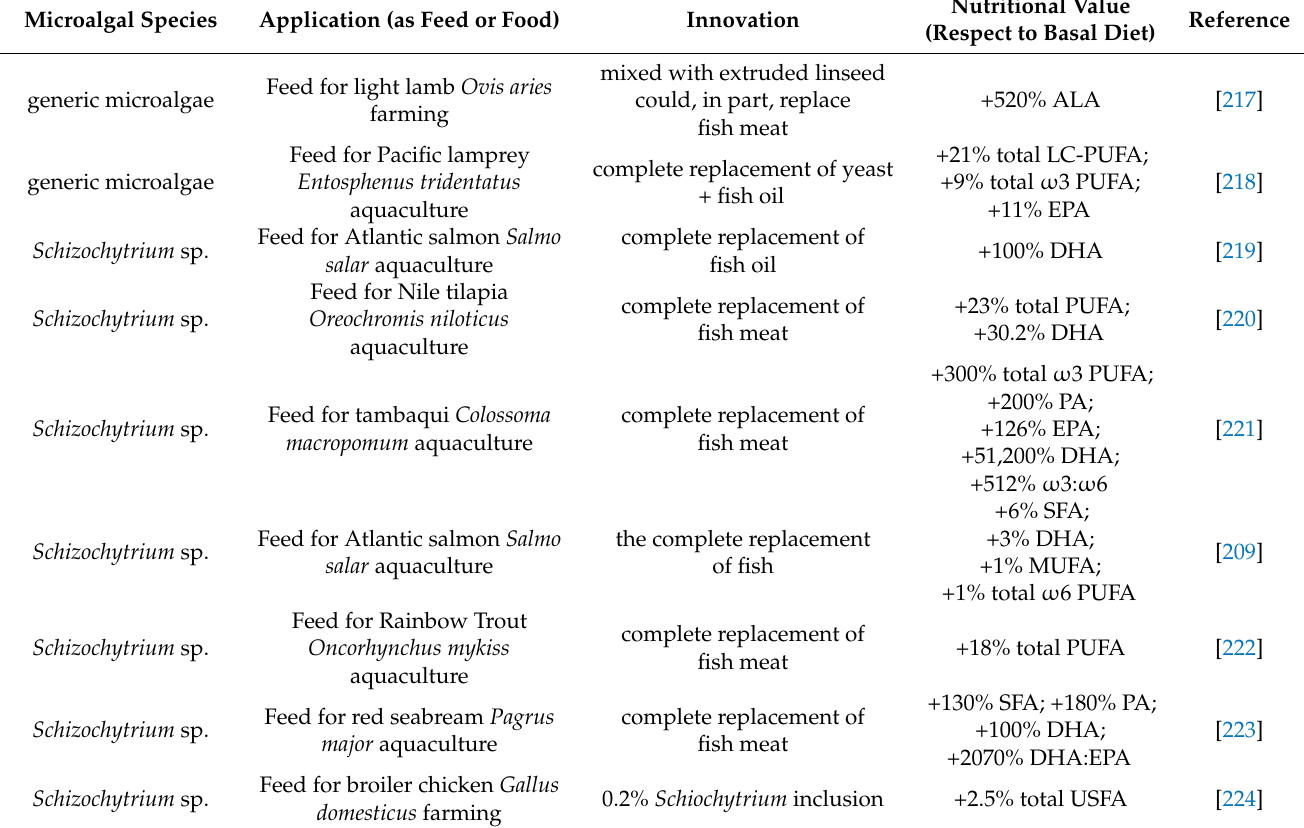
Table 3. Microalgae and their derivatives used as feed in farming or aquaculture. The table includes microalgal species involved, application as feed, innovations, and nutritional values indicated as percentage increase respect to a basal diet. Microalgal Species Application (as Feed or Food) Innovation